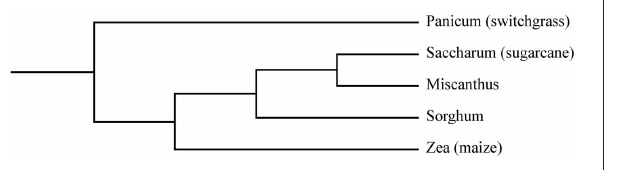
FIGURE 1 | Phylogenetic tree depicting the relationships between the C4 grasses maize, miscanthus, sorghum, sugarcane and switchgrass. Adopted from Lawrence and Walbot